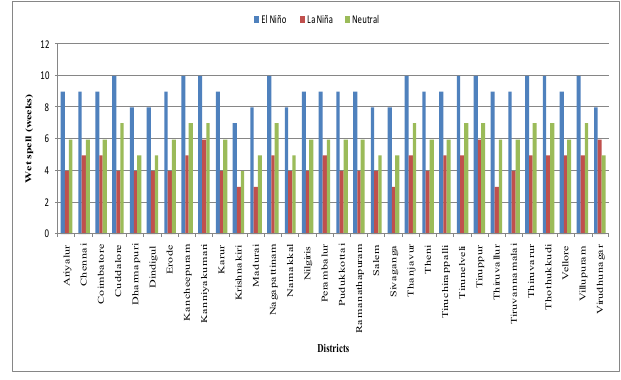
Figure 2. ENSO Effect on wet spell in different districts of